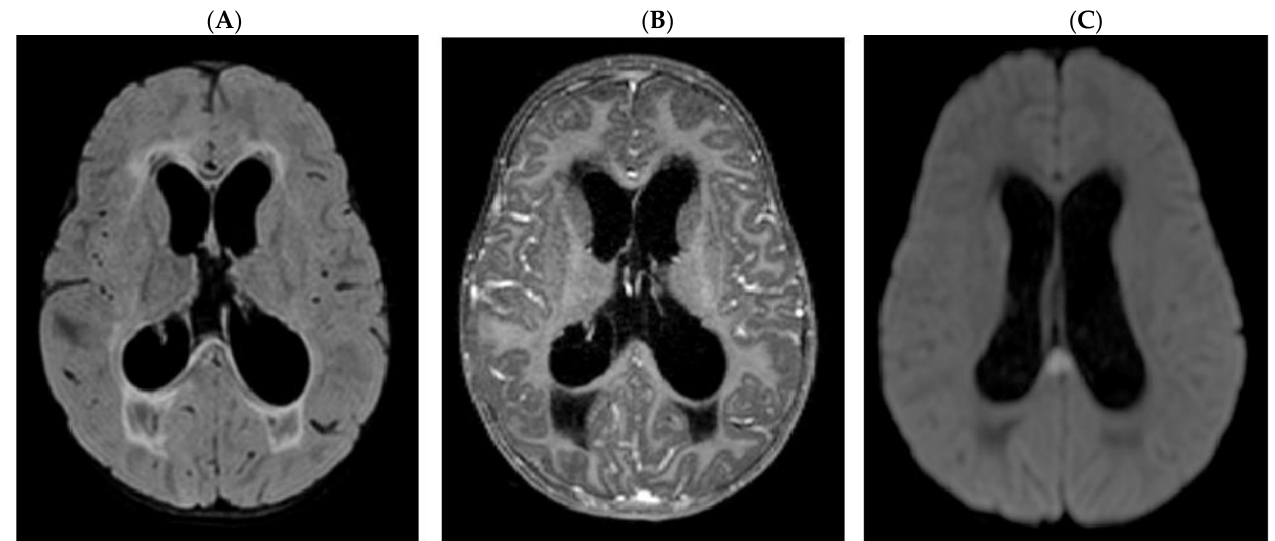
Figure 1. Brain magnetic resonance: ( A ) FLAIR axial scans showing hydrocephalic dilatation of the lateral ventricles and the third ventricle with marked transependimal resorption of CSF; in T1 TSE, absence of contrast enhancement ( B ). ( C ) in DWI axial scans ischemic lesions in the splenium of the corpus callosum.